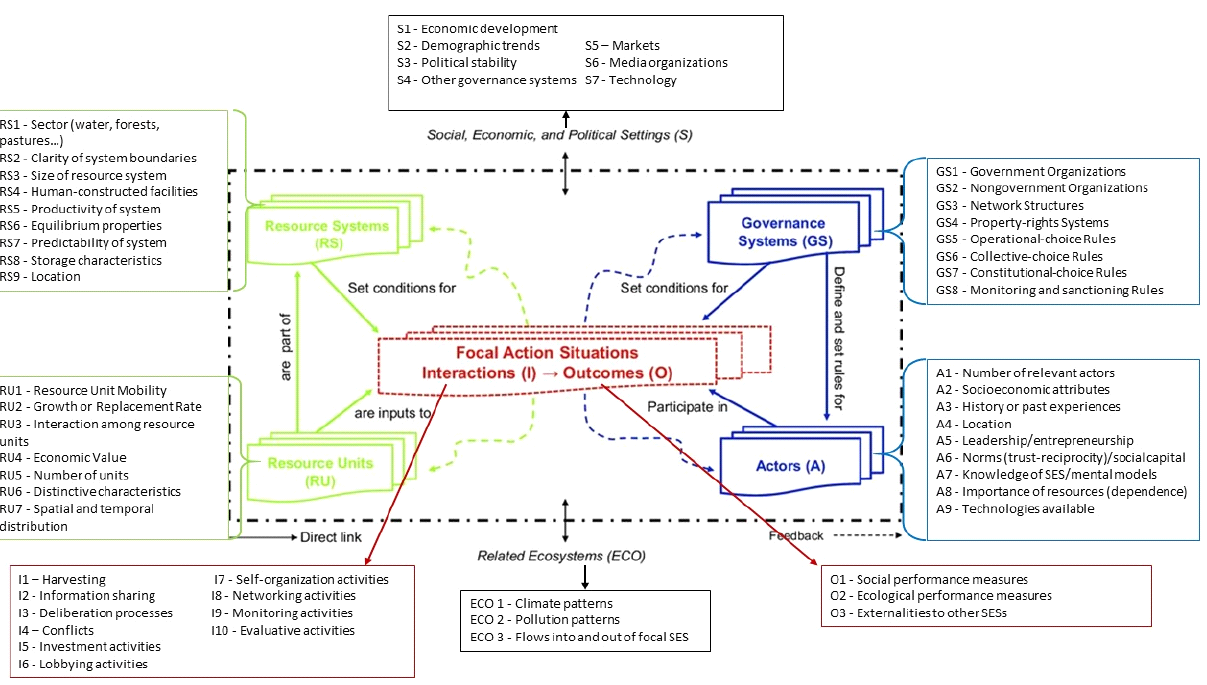
Figure 1. SES framework and second tiers (source: McGinnis and Ostrom, 2014).